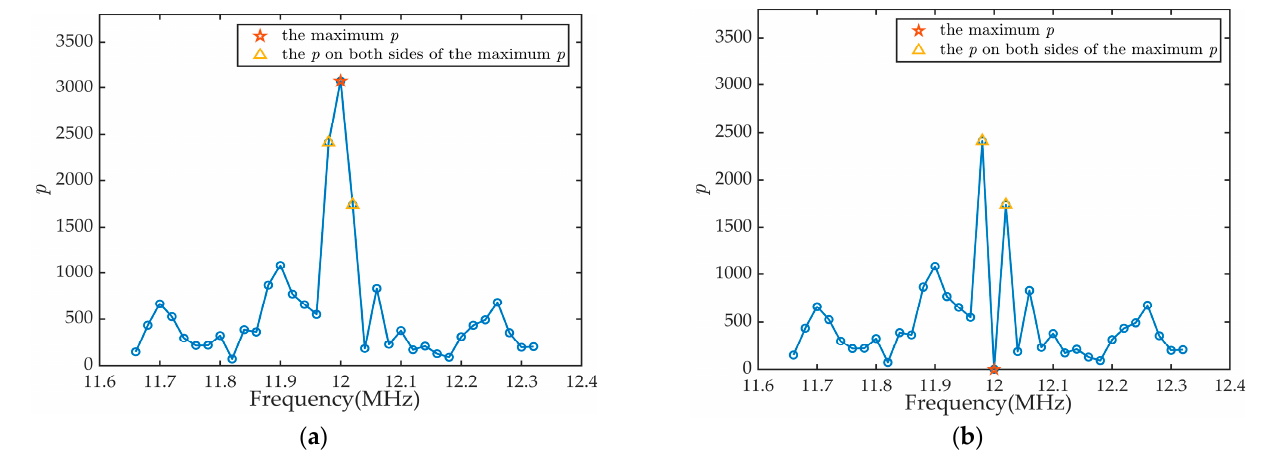
Figure 4. Partial enlargement of the spectrum at 12 MHz. ( a ) Partial enlargement of the spectrum shown in Figure 3a at 12 MHz. ( b ) Partial enlargement of the spectrum shown in Figure 3a at 12 MHz After using the zero-setting method.